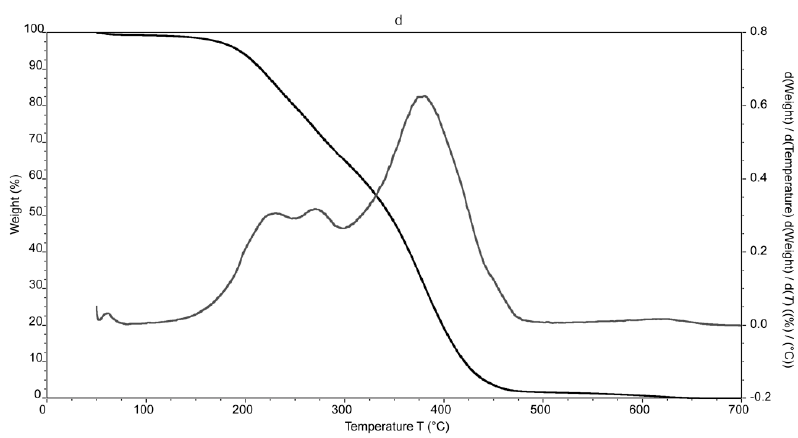
Figure 2. ( a ) Thermogravimetry/derivative thermogravimetry (TG/DTG) curves of coffee silverskin in oxygen atmosphere. ( b ) TG/DTG curves of coffee silverskin in nitrogen atmosphere. ( c ) TG/DTG curves of coffee silverskin fat samples in oxygen atmosphere. ( d ) TG/DTG curves of coffee silverskin fat samples in nitrogen atmosphere.